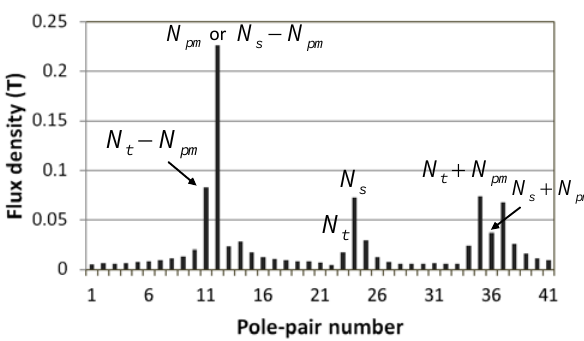
Figure 8. Harmonic spectrum of the airgap flux density.